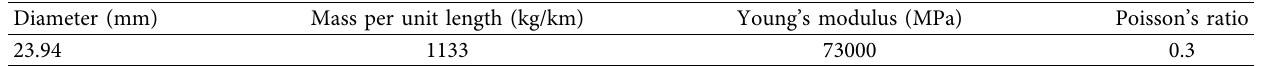
Figure 5: Full-scale transmission test lines and iced conductor. (a) Picture of the test tower-line test system. (b) Artificial D-shaped icing model. Table 2: Mechanical parameters of LGJ-300/40 conductor.